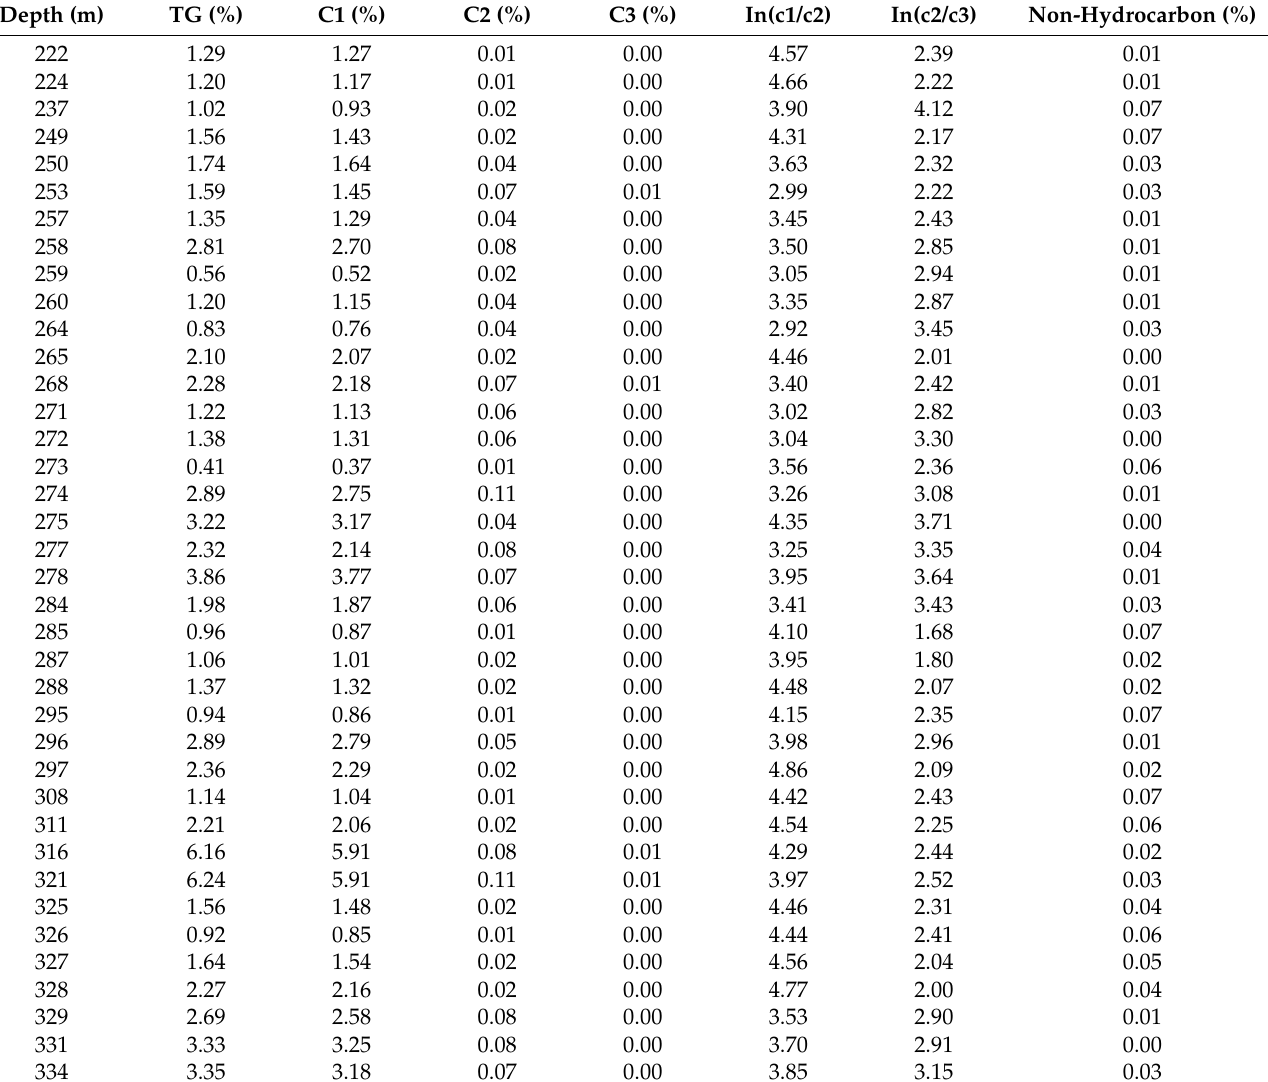
Table 5. Natural gas composition results from the Hengtongshan